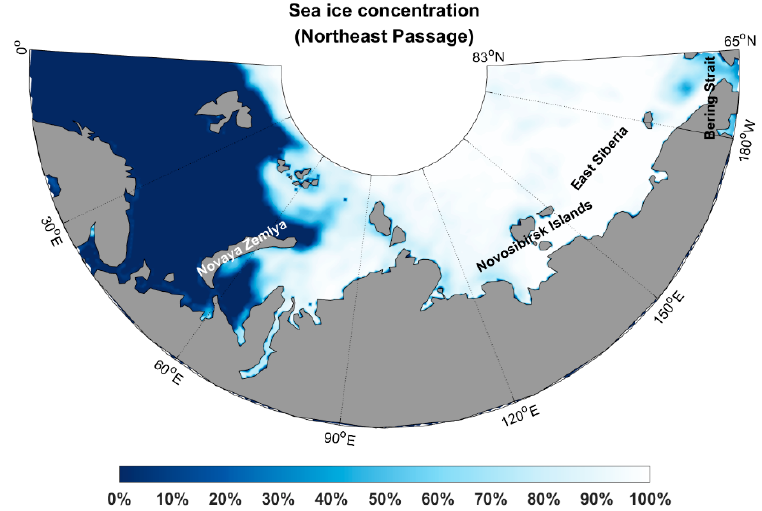
Figure 1. Schematic diagram of the sea area of the Northeast Passage (15 December 2018). Gray represents land, blue represents open water, and white represents sea ice.